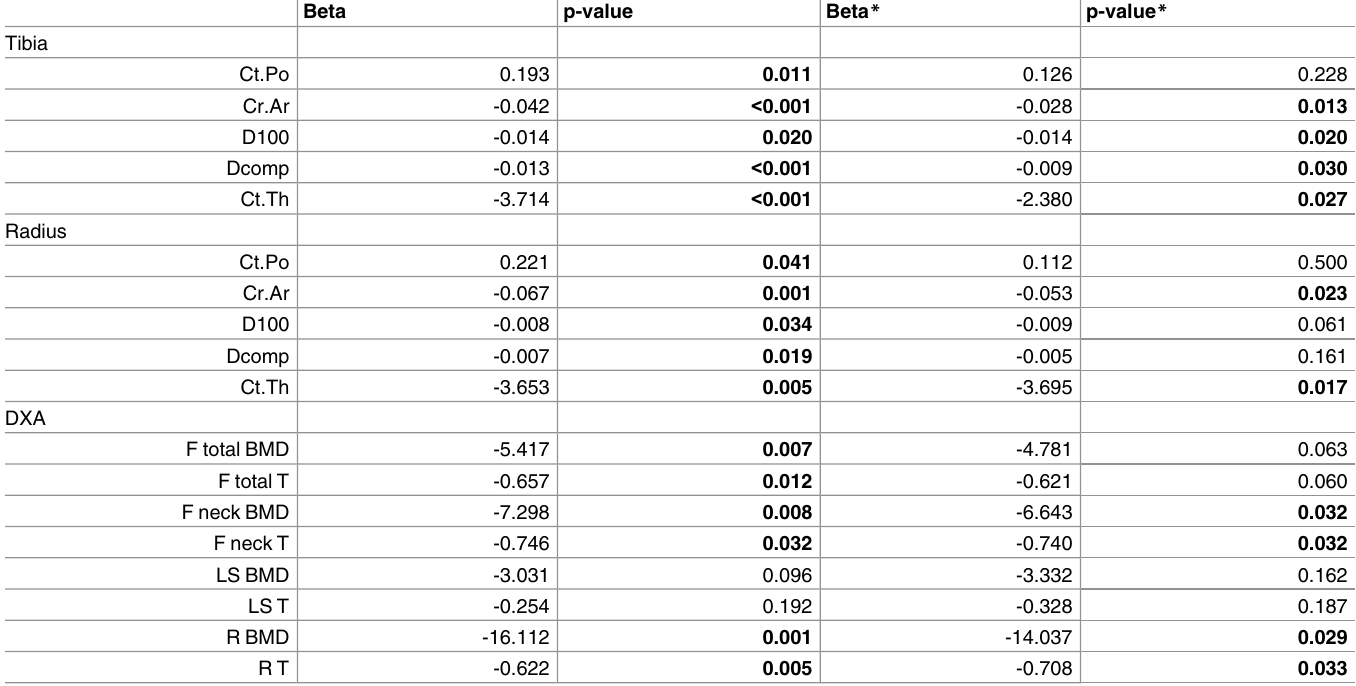
Table 3. Presenceof fracture discriminated by DXA and cortical HR-pQCT parameters.